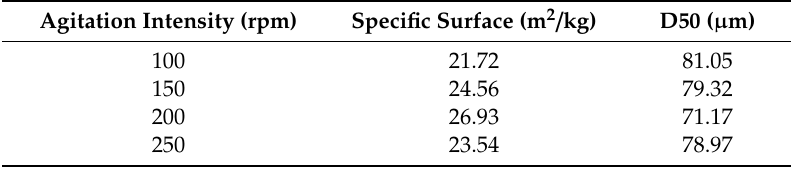
Figure 5. XRD patterns of the NH 4 ReO 4 recrystallization particles at different stirring speeds .